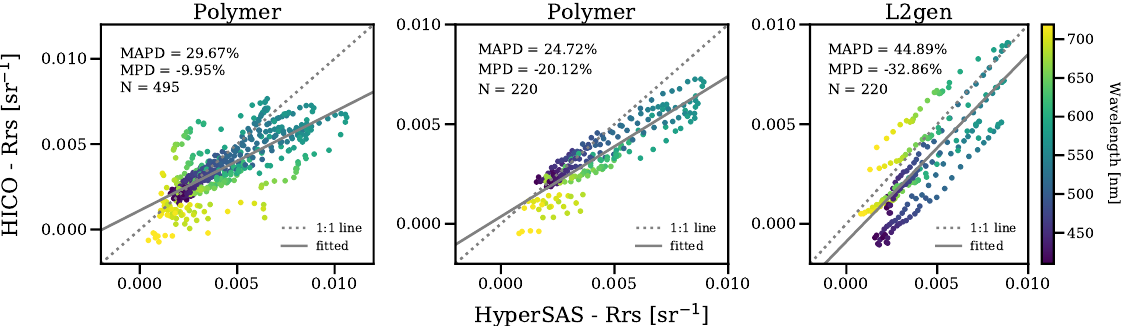
Figure 5. Scatterplots of HyperSAS-Rrs versus HICO-Rrs for the 410–719 nm spectral range: All Polymer match-ups ( left ), and Polymer ( centre ) and L2gen ( right ) coincident